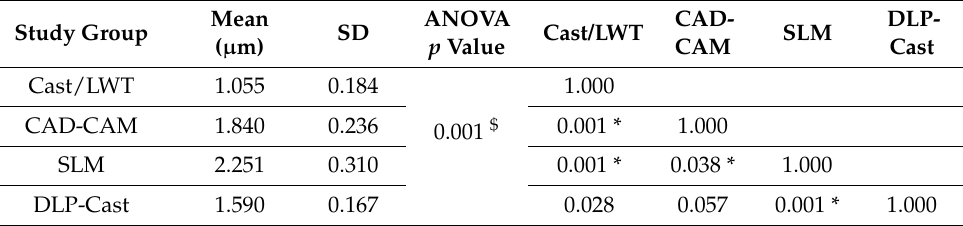
Table 1. Comparison of surface micro-roughness of the CoCr copings.